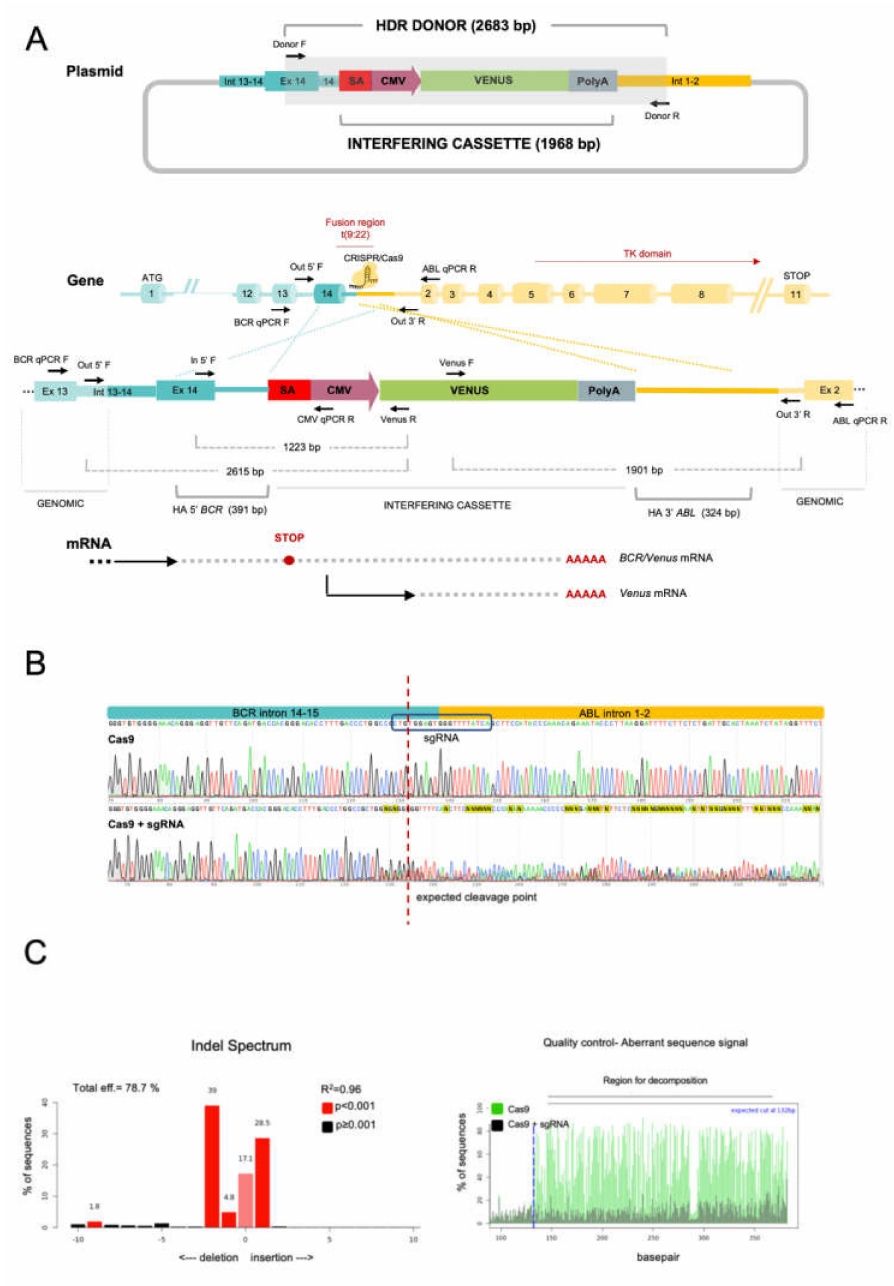
Figure 1. ( A ) Schematic representation of the CRISPR-Trap system plasmid and the target region of BCR/ABL fusion gene and the plasmid harboring the interfering cassette flanked by homology arms, containing a splicing acceptor sequence (SA), the CMV promoter (CMV) and the Venus fluorescent protein coding sequence. Black arrows represent oligos used to obtain the HDR donor molecule by PCR. CRISPR/Cas9 expected cut at BCR/ABL target sequence. The resulting BCR/ABL sequence after homology directed repair using interfering cassette as DNA donor is shown. Introduction of the SA-CMV-VENUS sequence into the intronic region of BCR/ABL disrupts the reading frame of the oncogene, also promoting expression of the Venus reporter. ( B ) Sanger sequencing of the CRISPR target sequence. Cells electroporated with CRISPR/Cas9 showed a mixture of sequences at the expected cleavage point (dotted red line). ( C ) TIDE decomposition algorithm analysis of the edited sequence in Cas9 + sgRNA cells, showing high editing efficiency at the expected cleavage point. The left panel illustrates the aberrant sequence signal in Cas9 control cells (black) and Cas9 + sgRNA-edited cells (green) and the expected cleavage site (vertical dotted